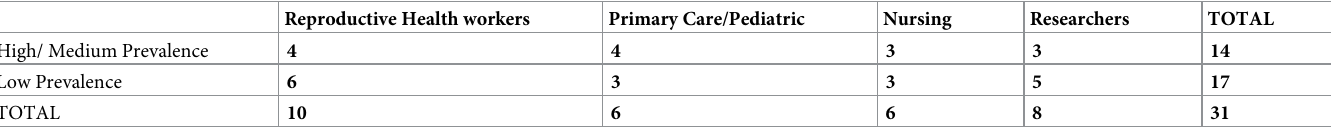
Table 1. Qualitative interview participants–region and profession. Reproductive Health